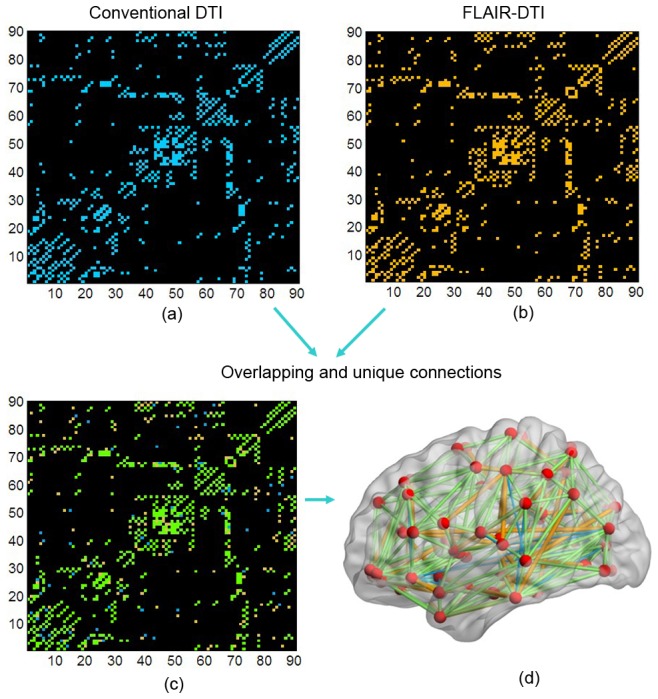
Backbone connectivity matrices of the human brain anatomical networks from the conventional DTI and FLAIR-DTI datasets.(a) For the conventional DTI datasets. (b) For the FLAIR-DTI datasets. (c) Overlapping results of the backbone networks for the conventional DTI and FLAIR-DTI datasets. Matrix elements in blue (yellow) represent the connections of the backbone network for the conventional DTI (FLAIR-DTI) datasets. Elements in green represent the common connections shared in the two backbone networks. (d) Rendering plot of edges on a cortex diagram to highlight the commonalities and differences between the edges in the two networks. Color scheme is the same as (c) but indicates edges. The numbers indicate the 90 brain regions (see Supplementary Materials Table S2 for more detail).